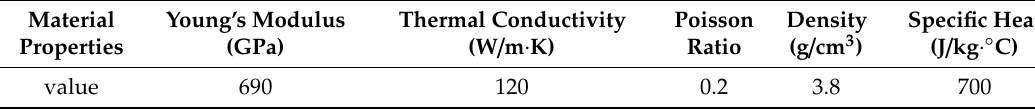
Table 4. Mechanical and physical properties of PCBN [32,33].